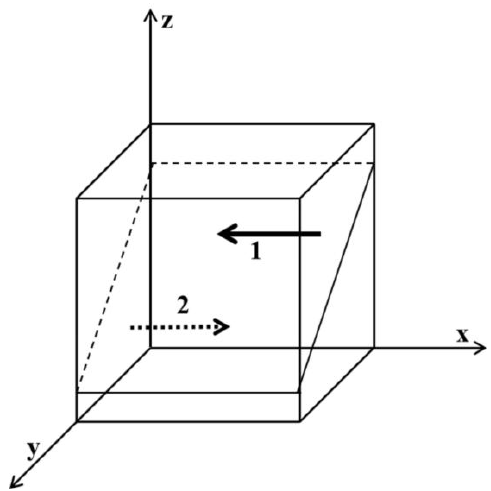
x . Region 1 is no